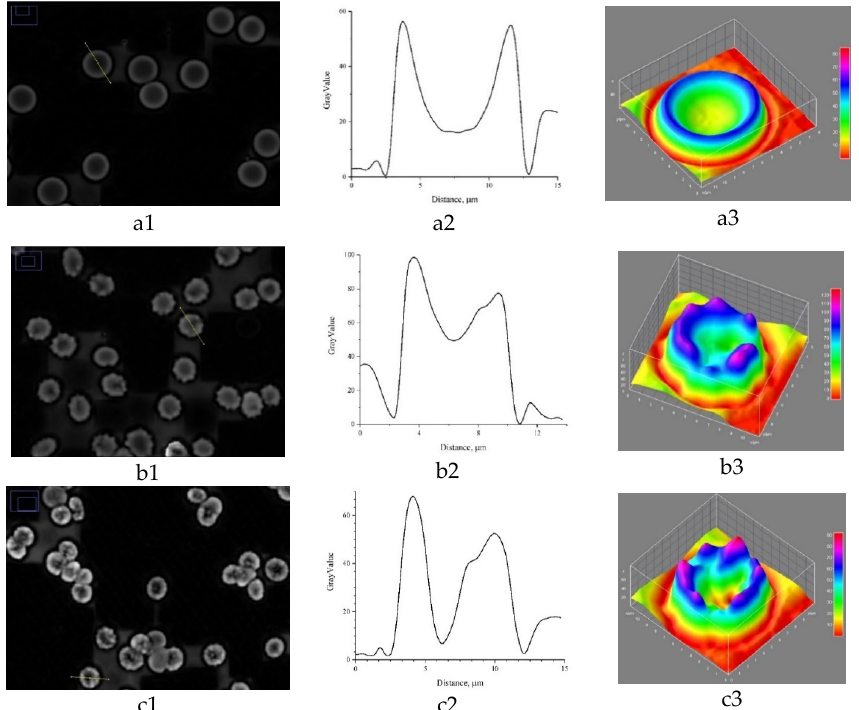
Figure 4. Image of a red blood cell from a healthy donor—( a ). Image of a red blood cell from a person with a confirmed diagnosis of COVID-19—( b , c ). ( 1 )—erythrocyte phase image; ( 2 )—erythrocyte profile; ( 3 )—3D model of erythrocyte phase image.